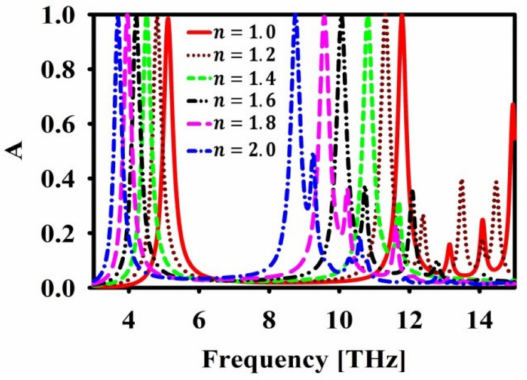
Figure 10. Effect of test medium refractive index ( n ) in absorption (A) spectra.